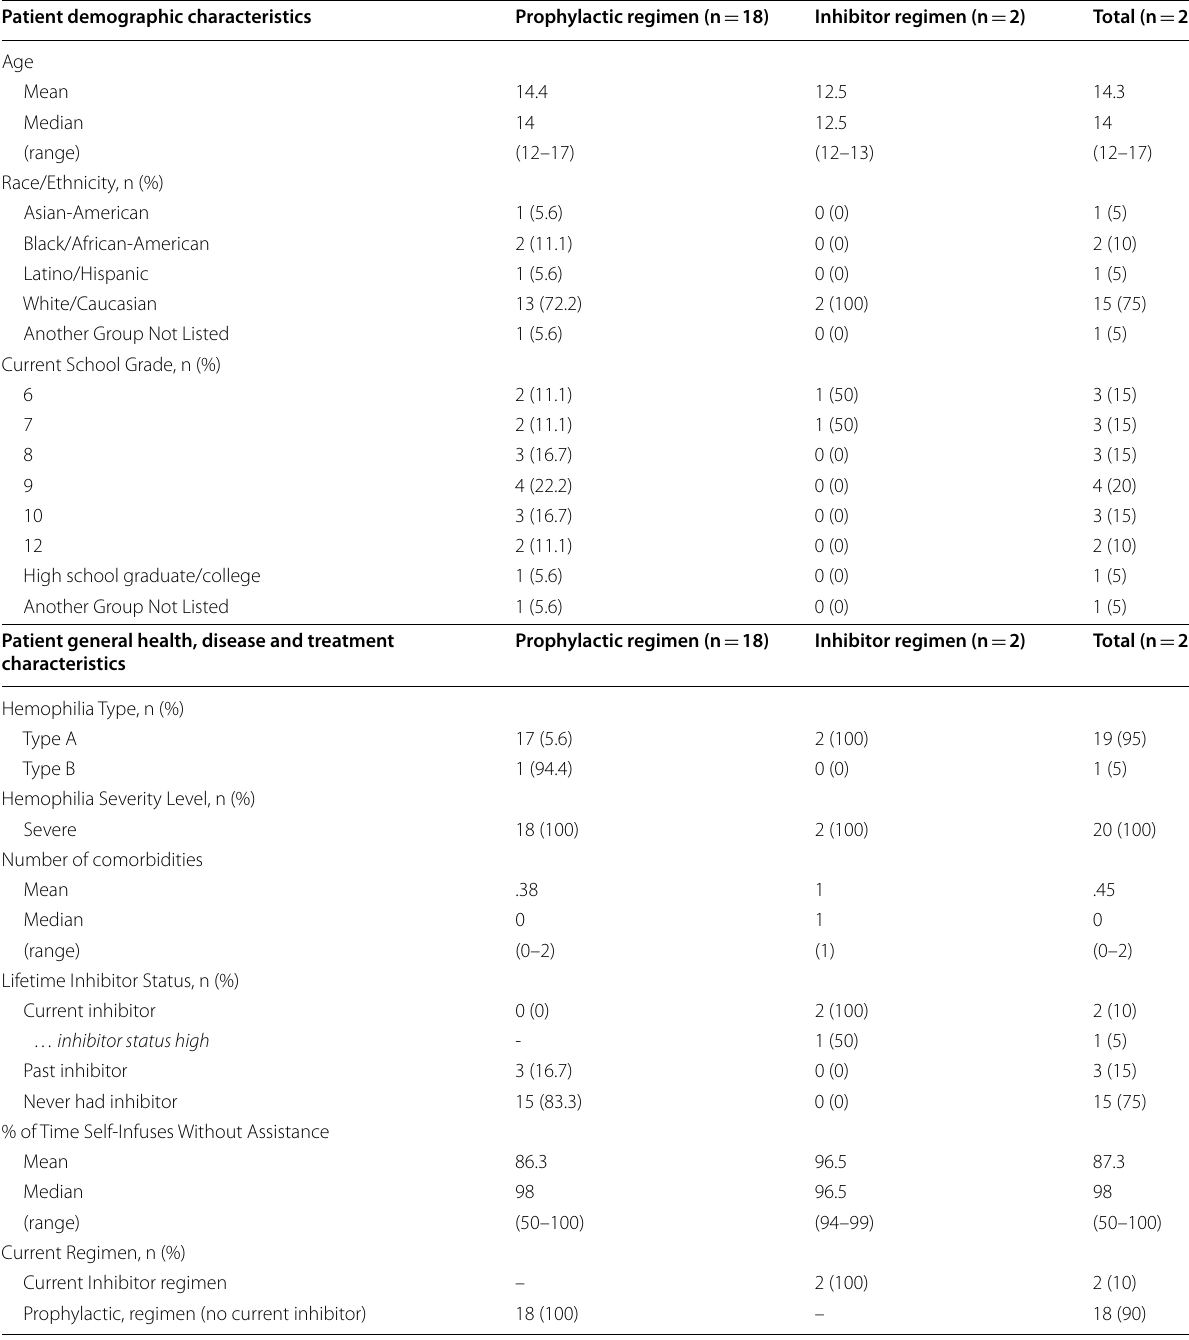
Table 2 Cognitive debriefing adolescent respondent sample: summary Patient demographic